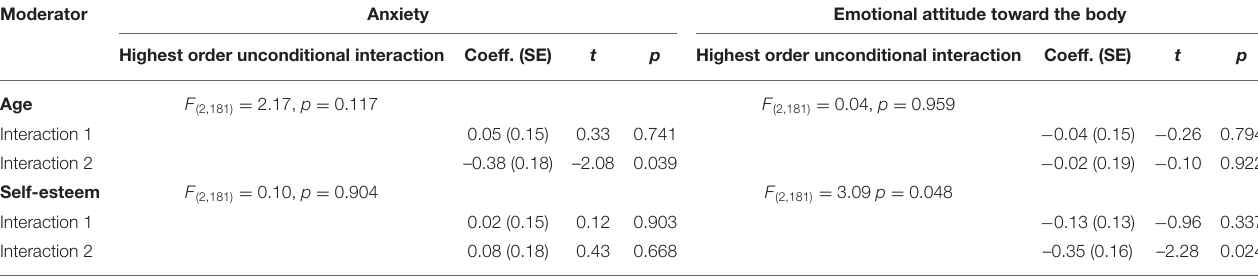
TABLE 4 | Age and self-esteem as moderators of the intervention effects. Moderator Anxiety Emotional attitude toward the body Highest order unconditional interaction Coeff. (SE) t p Highest order unconditional interaction Coeff. (SE)